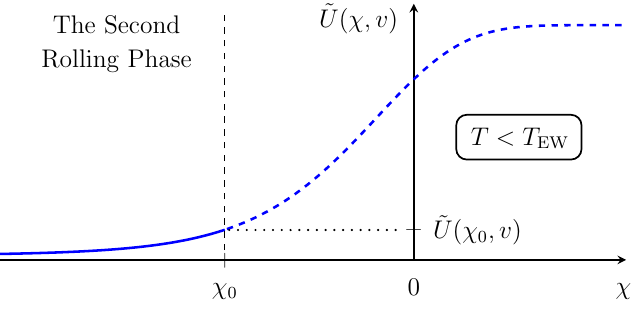
Figure 3 . The potential (2.3) with h = v with the kinetic term (3.1) in the canonical variable (cid:31)